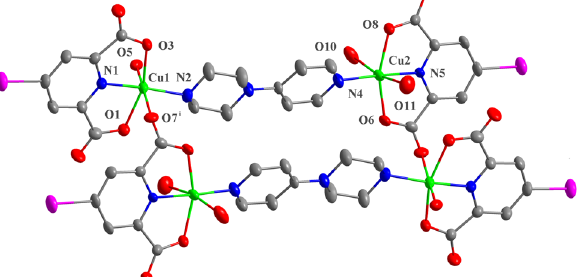
Table  : Data collection and